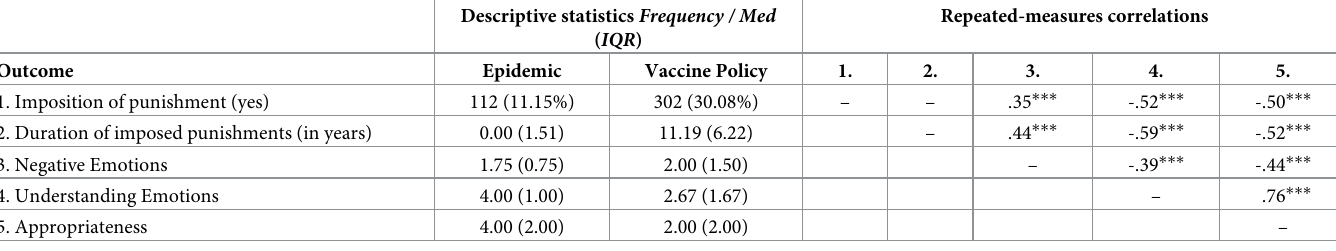
Table 1. Descriptive statistics and correlations of outcome variables (N =